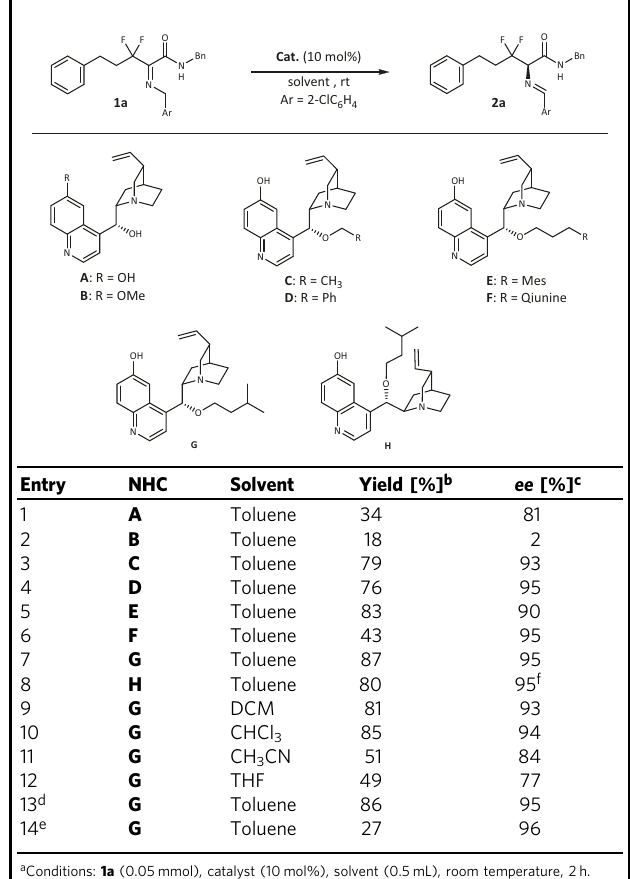
Fig. 1 Representative β , β -di fl uoro- α -amino acid derivatives. I : β , β - di fl uorophenylalanyl puromycin; II : 3,3-di fl uoro-3,4-dideoxy-KRN7000 analog; III :CCRF-CEM folypoly- γ -glutamate synthetase.